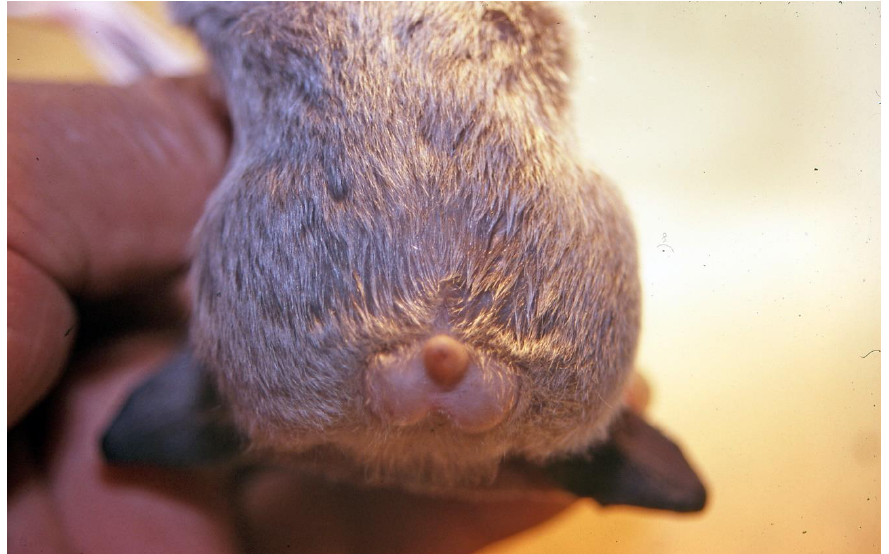
Figure 2. A male vampire bat captured while feeding in the wild, with a distended abdomen, not yet totally filled with blood. Salivary anticoagulants facilitate the maintenance of the blood flow during ingestion and in a liquid state within the digestive tract of the bat. Blood of prey, with strong resistance to vampire bat anticoagulants induced by an appropriate delivery, could coagulate within the digestive tract of the bat, making both digestion and elimination of excess water difficult.